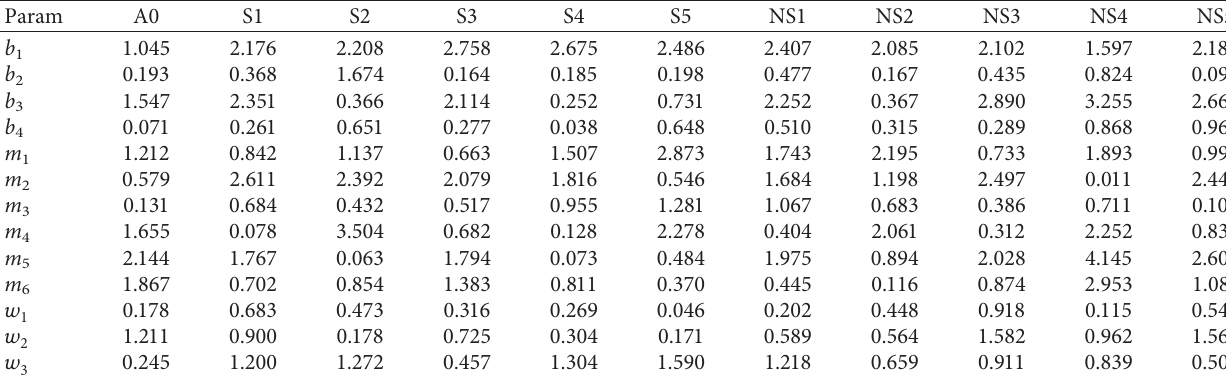
Figure 8: Effects of compressive strength on drying shrinkage. (a) SF group. (b) NS group. Table 4: The curve-fitting parameters of drying